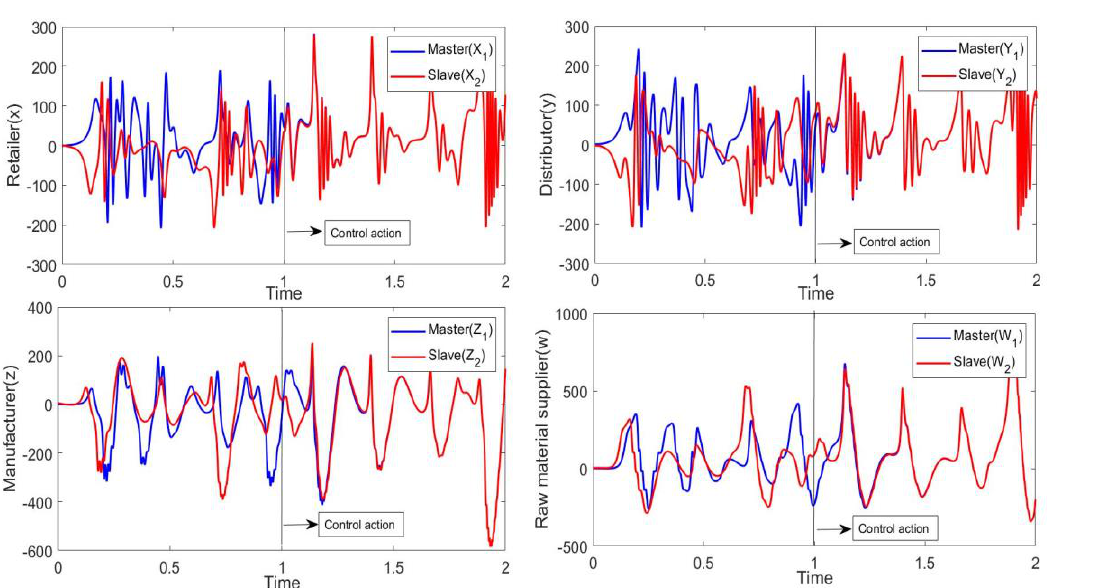
Fig. 6. Synchronization of two hyper chaotic Qi systems with different initial conditions under the proposed control